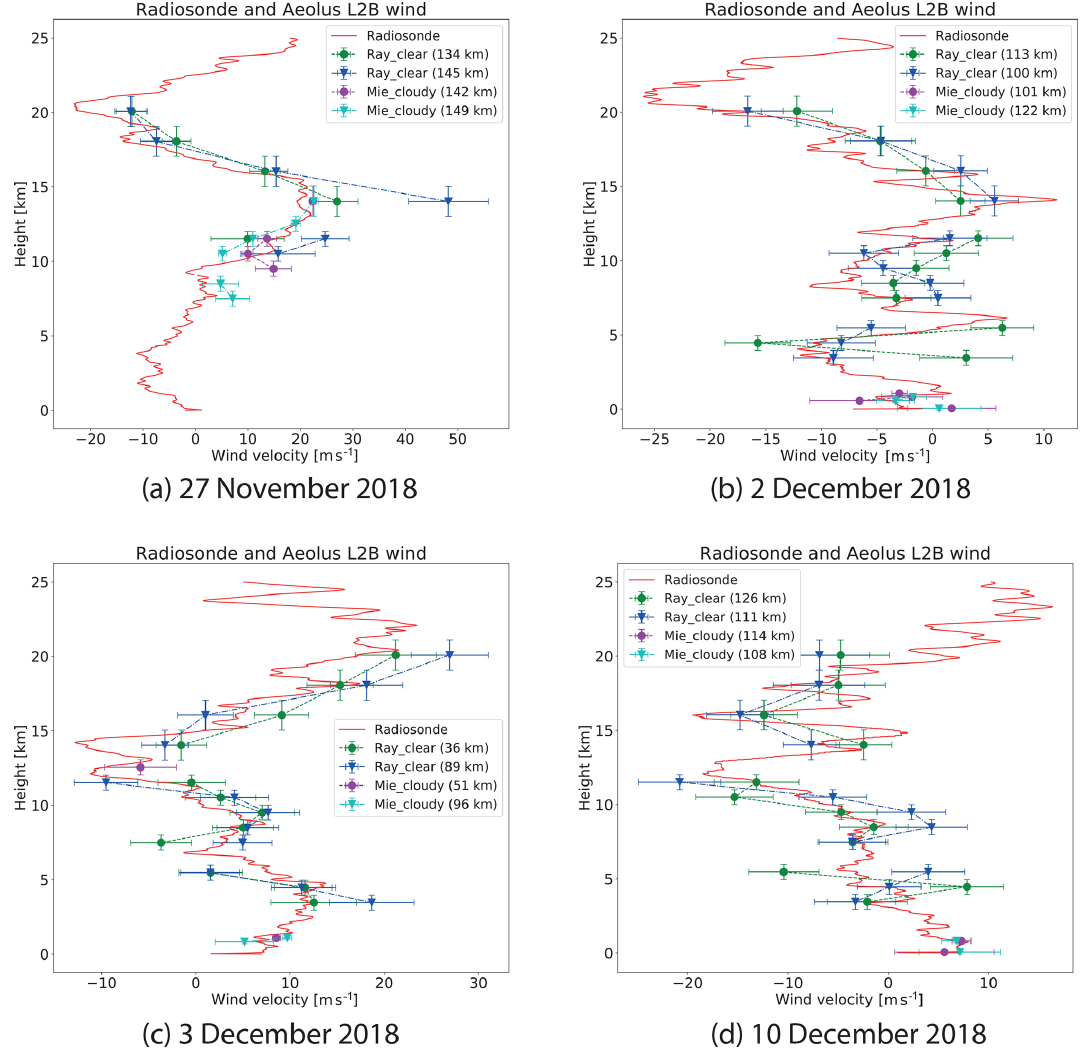
Figure 9. Wind velocity profiles measured by the radiosonde (red) with the two closest Aeolus L2B Rayleigh clear (green and blue) and Mie cloudy (magenta and cyan) profiles of all four remaining validation cases obtained during the RV Polarstern cruise (see Fig.